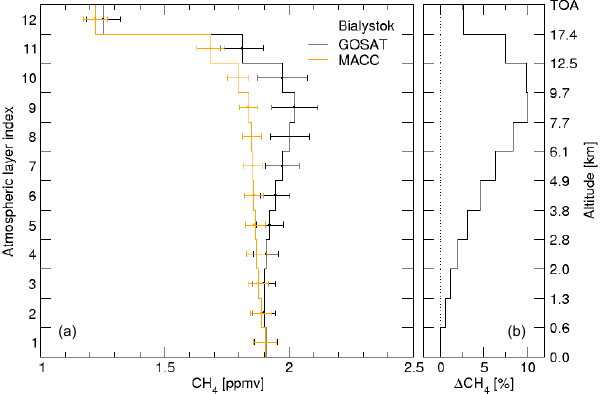
Figure 5. (a) Average methane profile retrieved from GOSAT-TIR spectra (black) over TCCON station Bialystok and from the MACC repository (orange) scaled such that the total column equals the cor- responding TCCON total column measurement. The bars indicate the spread in the data ensemble. (b) The relative difference between the averaged retrieved GOSAT TIR and MACC methane profiles. It is noted that the two panels have different horizontal scales.